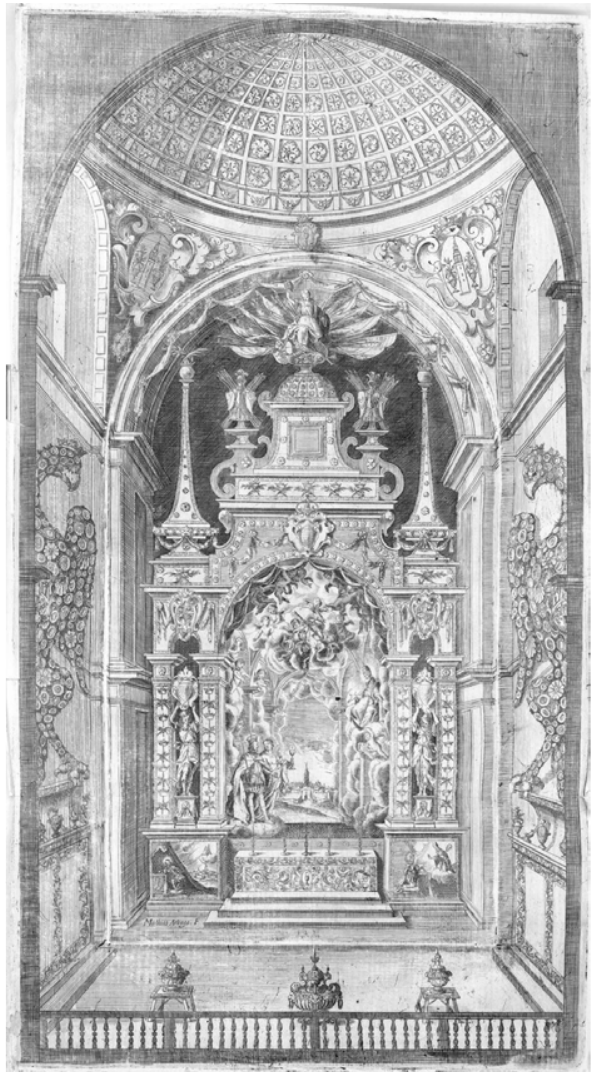
Figure 11: The ephemeral altarpiece erected in the Sagrario, Seville Cathedral, 1671. Source: Torre Farfán 1671: 227. Image reproduced with permission from the Biblioteca de la Universidad de